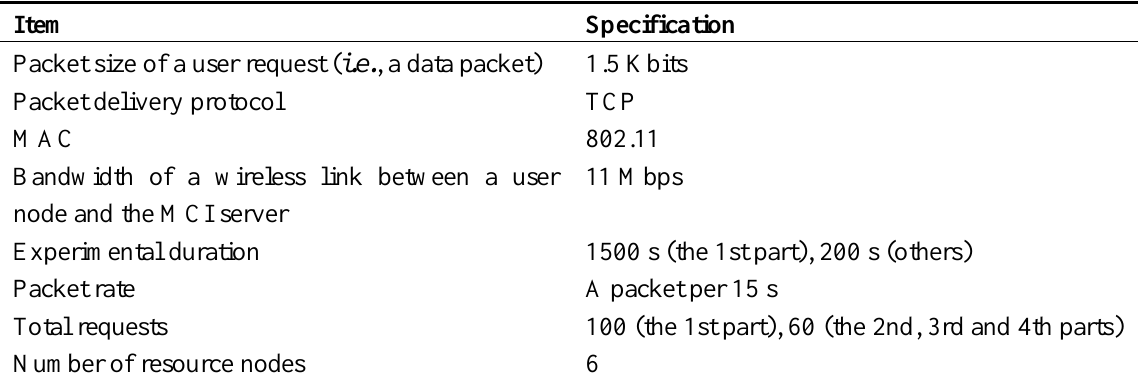
Table 11. The parameters of the